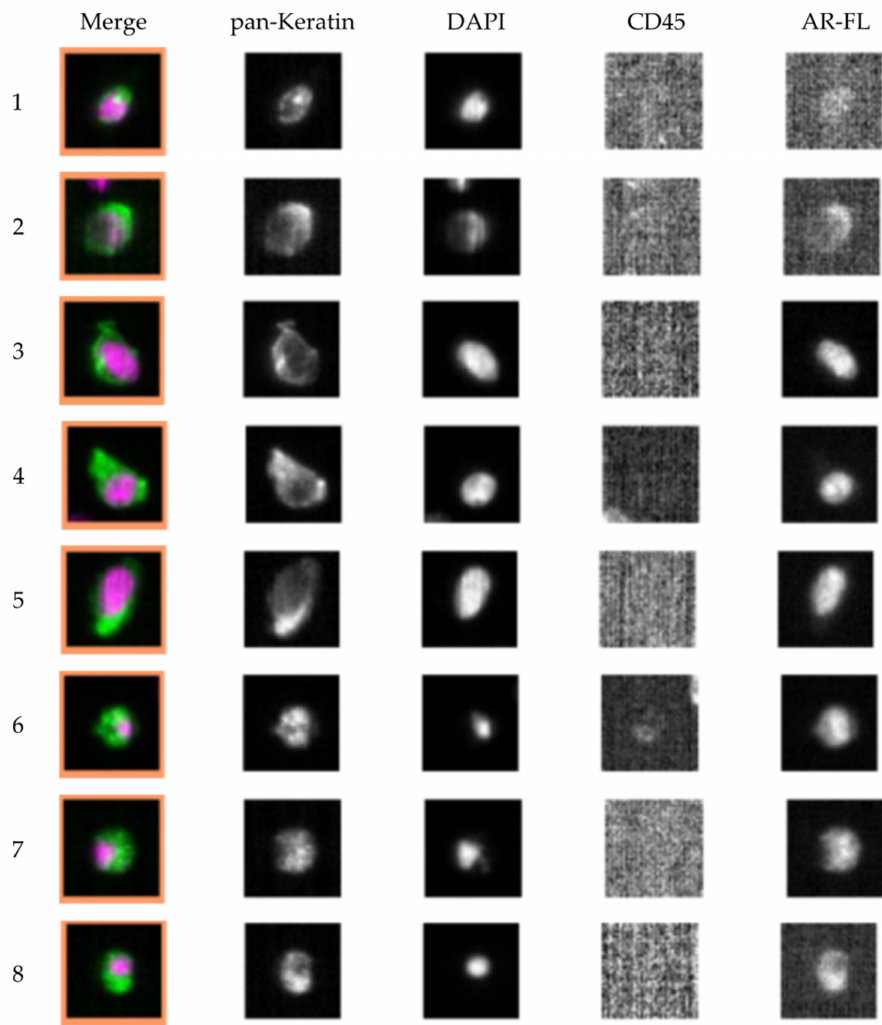
Figure 5. Representative CellSearch ® images of CTCs and AR-FL staining from a single prostate cancer patient case. This patient had detectable AR-FL negative ( 1 ), weakly positive ( 2 ), nuclear AR-FL positive ( 3 – 5 ) and cytoplasmatically AR-FL positive ( 6 – 8 )